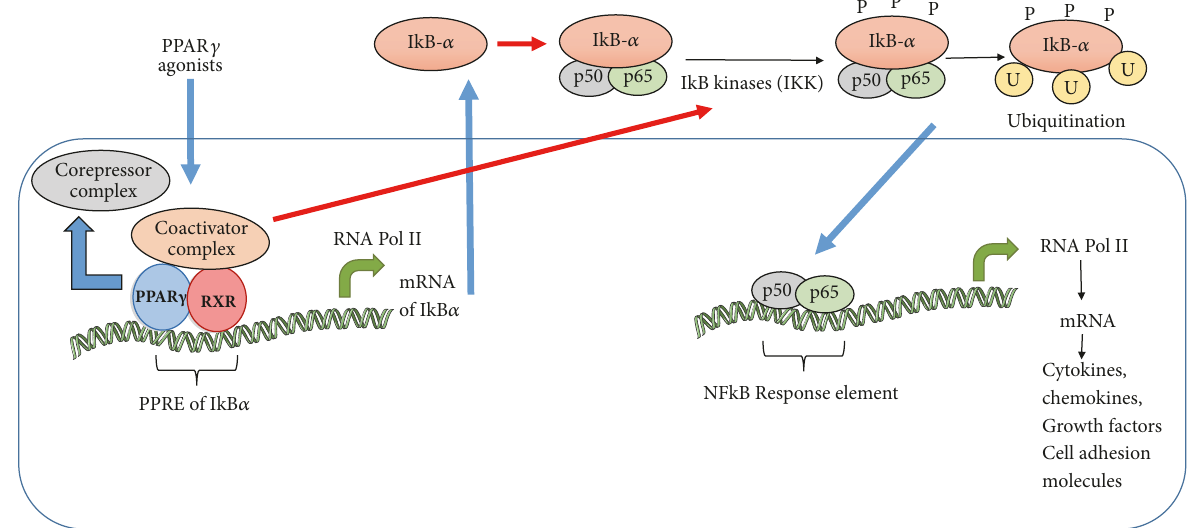
Figure 4: PPAR 𝛾 agonist mediated transrepression of NF-kBsignaling. Activationof PPAR 𝛾 occursuponbinding of PPAR 𝛾 agonists through association of heterodimer with coactivator complex to form a transcriptional complex. This complex binds to the PPAR 𝛾 response element (PPRE) of IkB 𝛼 gene, thereby inducing the expression of IkB 𝛼 . An additional transrepressive mechanism involves inhibition of IKK 𝛼 / 𝛽 , an upstream kinase of IkB 𝛼 . Consequently, degradation of IkB 𝛼 and subsequent nuclear-translocation and activation of NF-kB (p50/p65) fail to occur, resulting in inhibition of inflammatory gene